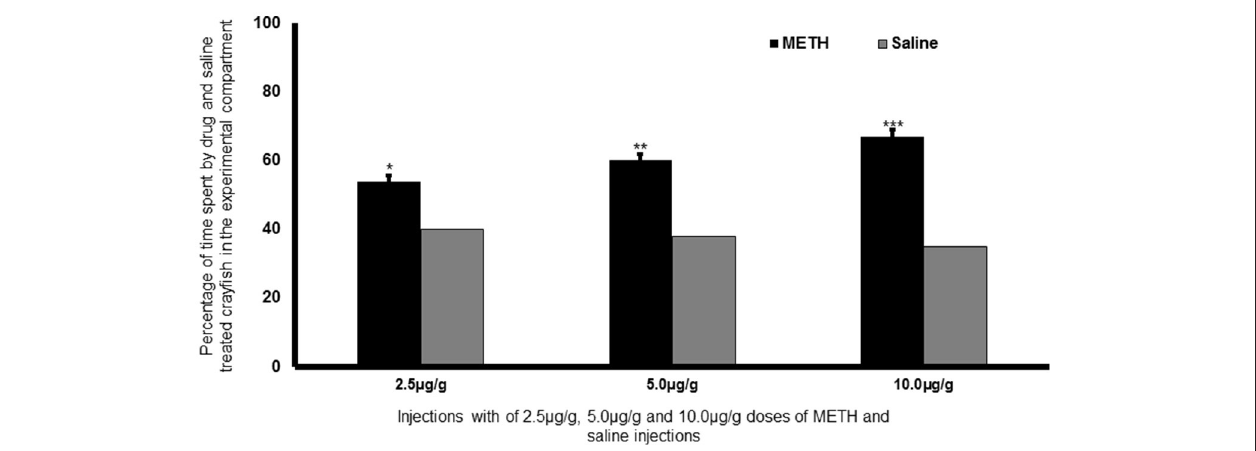
FIGURE 2 | Repeated infusions of METH induced CPP in crayfish in the hard-textured experimental arena. There was a significant preference for the hard-textured compartment vs. soft textured-compartment following 5 days of injections with 2.5, 5.0, and 10.0 µ g/g doses of METH, such that a conditioned place preference was established. Post hoc test comparison indicates that crayfish treated with 5.0 and 10.0 µ g/g (*** P < 0.05 and ** P < 0.01) were higher and different from the crayfish treated with 2.5 µ g/g of METH (* P < 0.001) when compared with the saline-paired crayfish. The METH-conditioning effects were shown when crayfish that were treated with METH were paired with the naturally non-preferred hard environment. ANOVA [ F (4, 30) = 21.13; P < 0.001] reveals a significant effect, indicating a larger amount of time being spent in the METH-paired, hard-textured compartment when compared to saline conditioning, such that a conditioned place preference was established. The ANOVA factor revealed that the METH conditioning effect on crayfish was high (statistical power; 1 - β = 1.00) indicating that METH-induced CPP can be consistently replicated with a high degree of reliability.